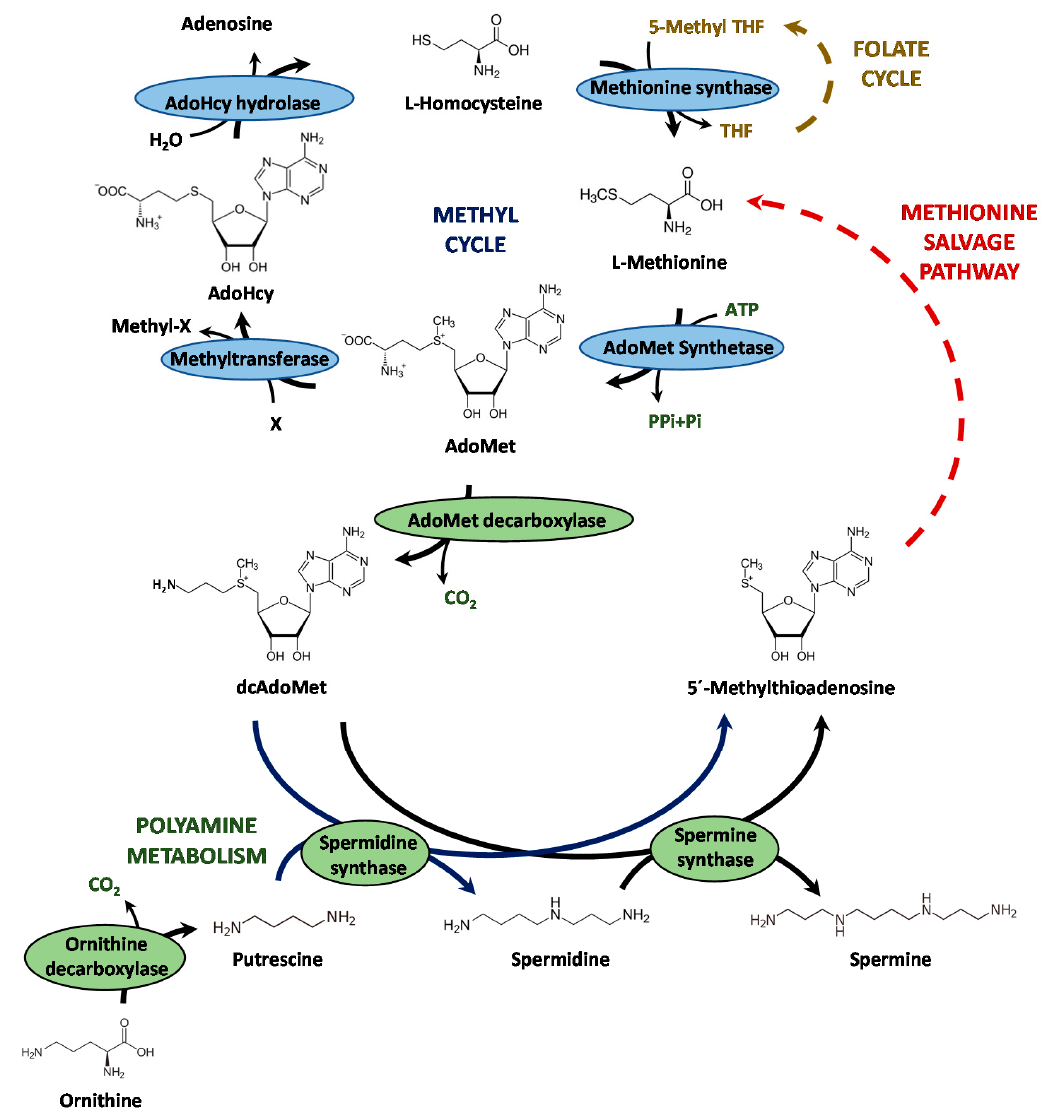
Figure 1. Schematic representation of the methyl cycle and the polyamine biosynthetic pathway. AdoMet: S-adenosyl-L-methionine; AdoHcy: S-adenosyl-L-homocysteine; dcAdoMet; decarboxylated AdoMet; THF: tetrahydrofolate.